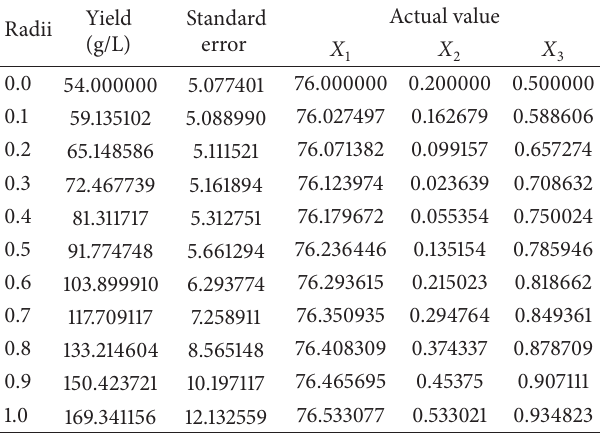
Table 8: Results of ridge